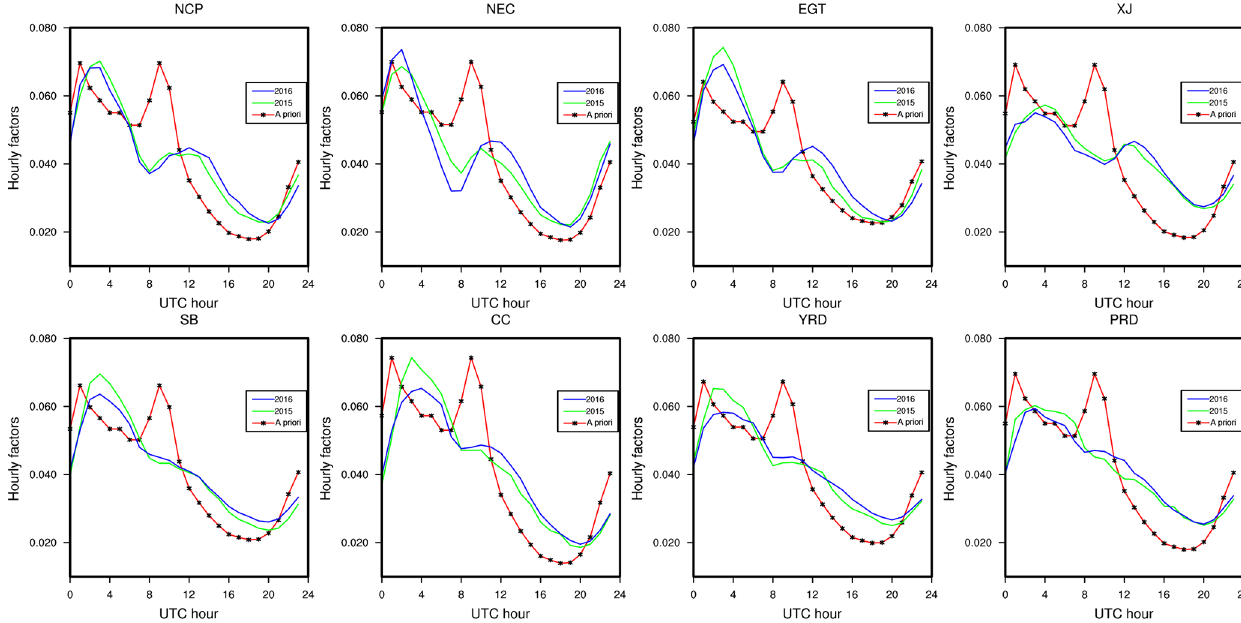
Figure 10. Hourly factors in the a priori emission inventory and those derived from the EMIS_DA experiment in eight regions.